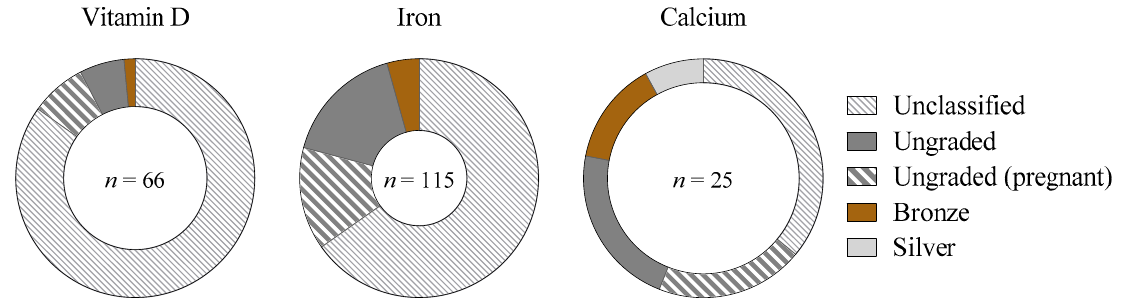
Figure 5. The proportion of studies classified into each tier [15] according to the standard of methodological control concerning ovarian hormonal profiles, as a proportion of the total number of studies including women across each supplement. Gold-standard (best-practice methodologies as detailed by Elliott-Sale et al. [19]), silver/bronze (achieve some, but not all, methodological considerations), ungraded (menstrual status is defined, but methodological control is insufficient to award bronze/silver/gold) or unclassified (insufficient information to provide a distinct participant classification, or a mixed female cohort in which individual menstrual status cannot be differentiated). Studies including pregnant women are highlighted separately to distinguish from studies not classifying participants.